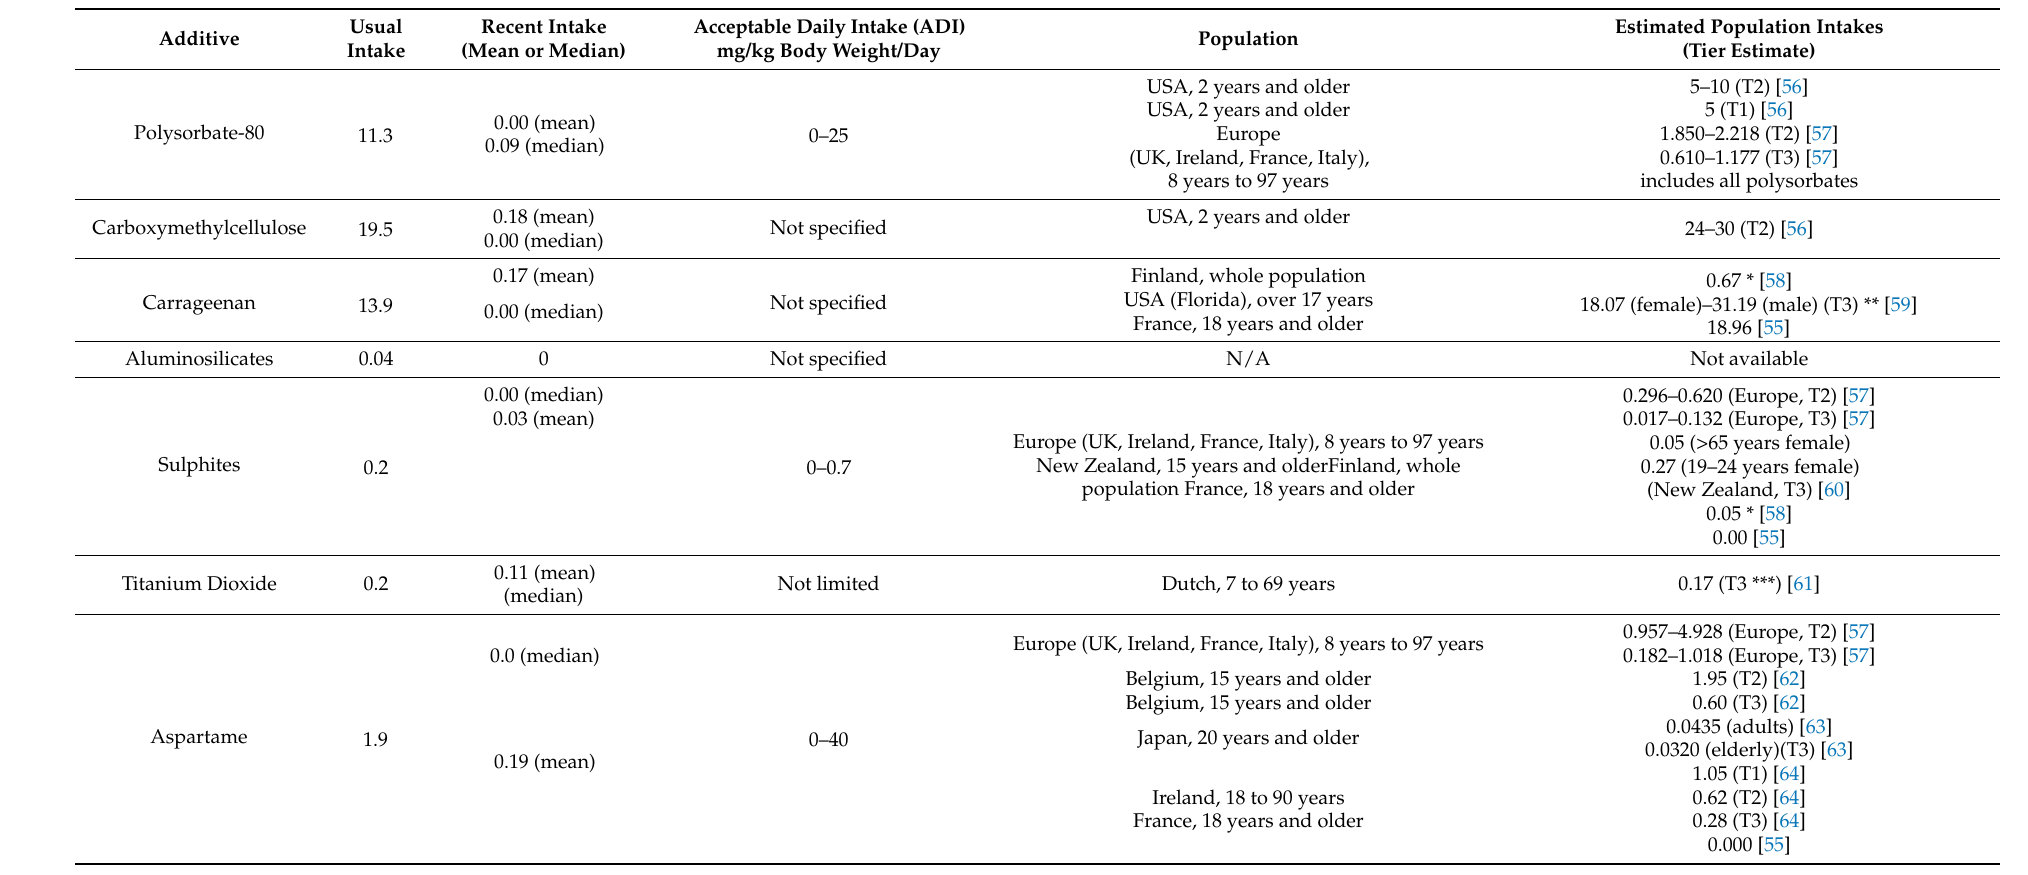
Table 4. Estimated usual and current (3 day) intake of additives in mg/kg body weight/day and comparisons to acceptable daily intake and estimated population intakes in various